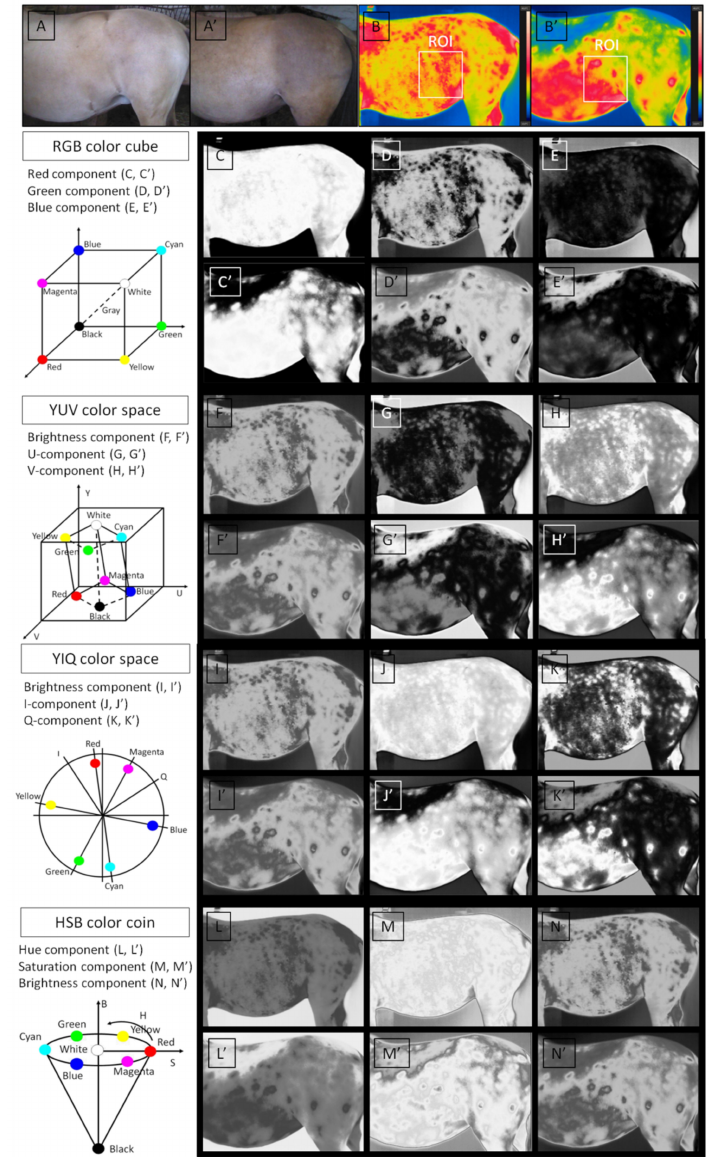
Figure 1. Thermal image processing for the analysis of image texture. Image acquisition, white light ( A , A’ ) and thermal image ( B , B’ ); segmentation of the region of interest (ROI) ( B , B’ ); transformation to color models ( C – N’ ): RGB color model ( C – E’ ), YUV color model ( F – H’ ), YIQ color model ( I – K’ ), and HSB color model ( L – N’ ). Subfigures ( A – N ) and ( A’ – N’ ) represent non-pregnant and pregnant mares,